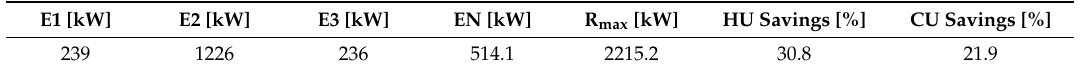
Table 3. Detailed information about the most beneficial Utility Path.